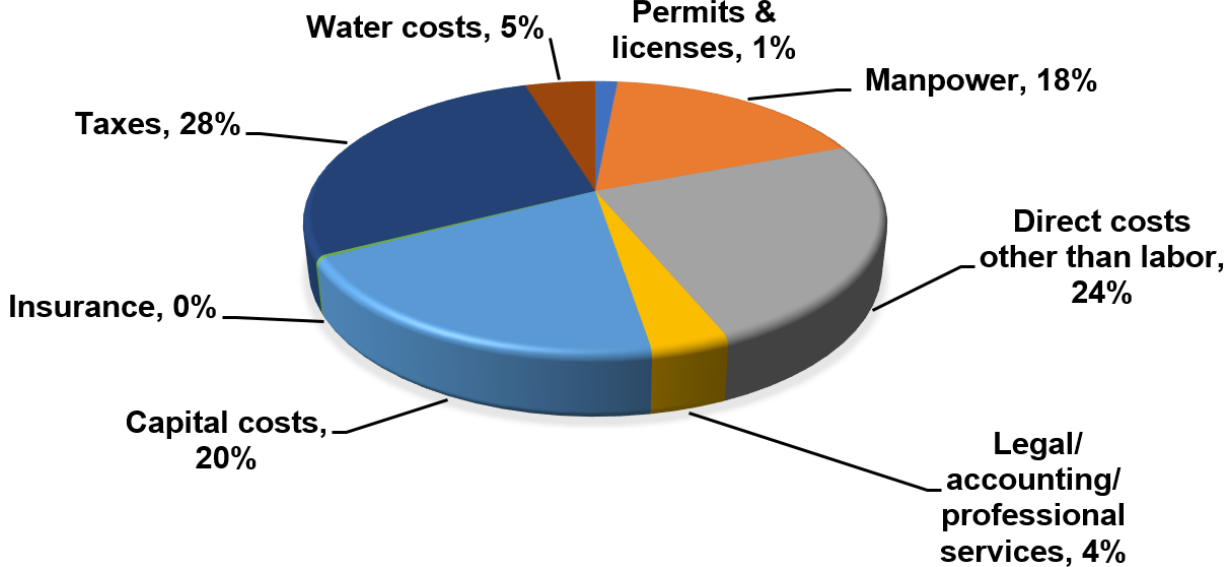
Figure 5. Regulatory costs by type of cost (% of regulatory costs).